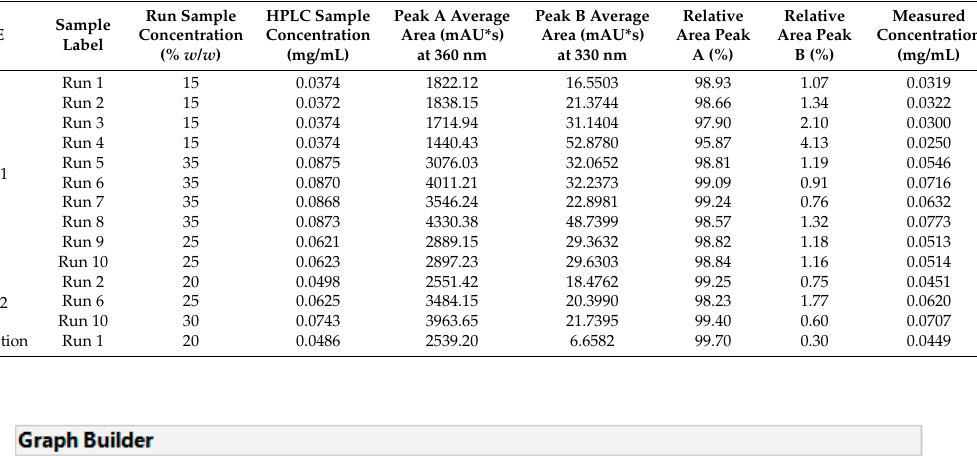
Table 8. Calculation of sample concentrations based on average peak areas at 330 and 360 nm for DoE1 = Screening Design, DoE2 = optimization and V = verification.